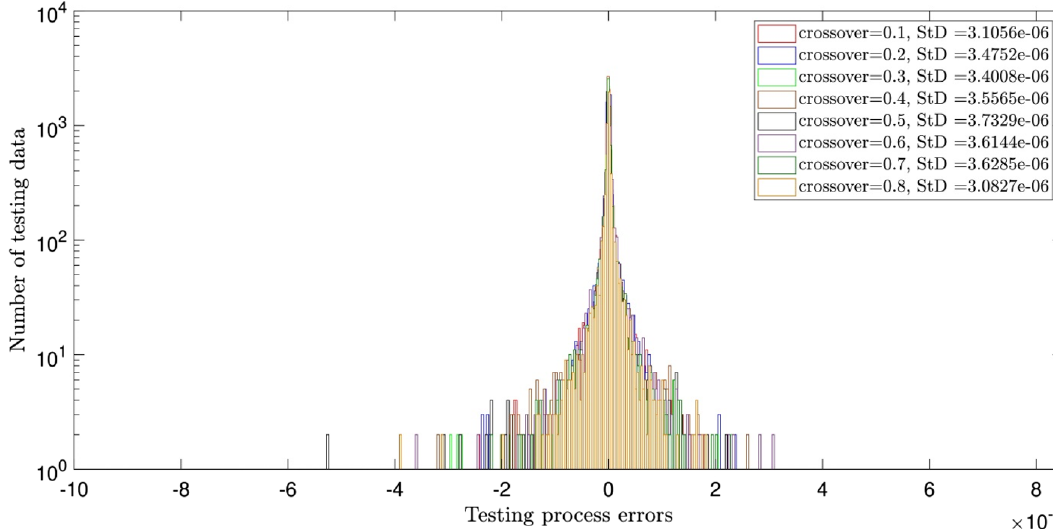
Figure 4. StD errors of learning processes considering different crossover with three inputs.